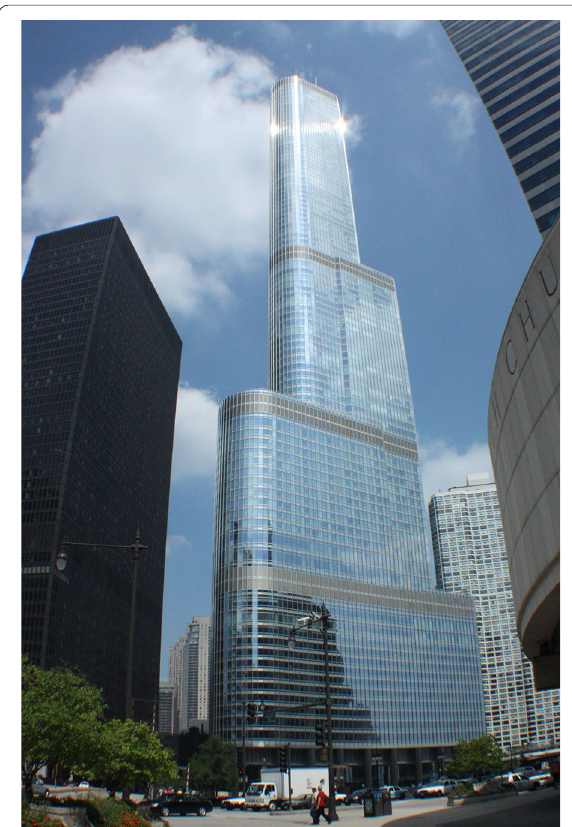
Fig. 23 The Hearts Tower in New York and its deconstructed